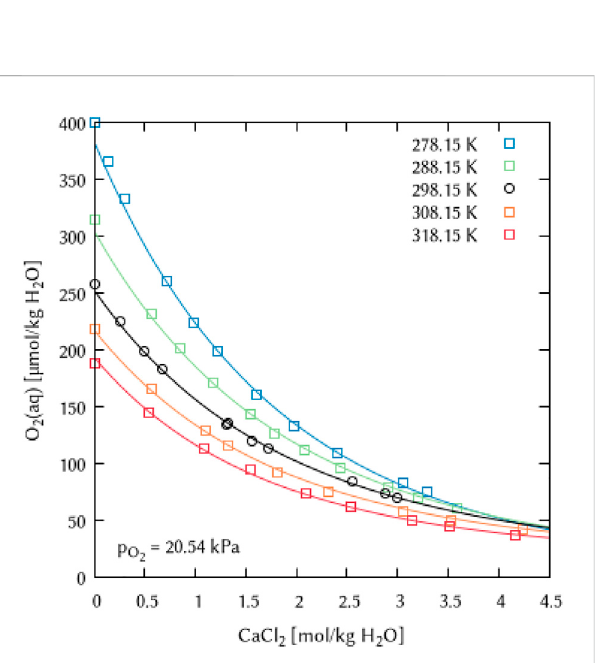
FIGURE 20 Modelling of the O 2 solubility in magnesium chloride solution as a function of temperature and MgCl 2 concentration. [Points: Experimental data from ○ Millero et al. (2002a) and □ Millero et al. (2002b), Lines: this